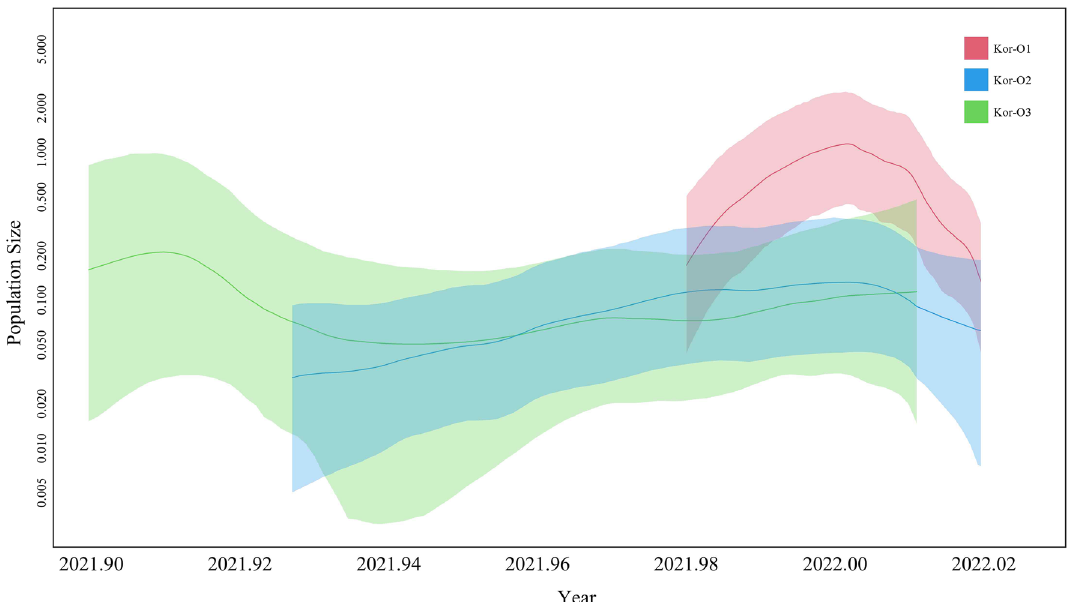
Figure 5. Viral population size change of each Omicron subgroup detected in South Korea. A line indicates the mean value of the viral population size, and 95% HPD is indicated by the solid